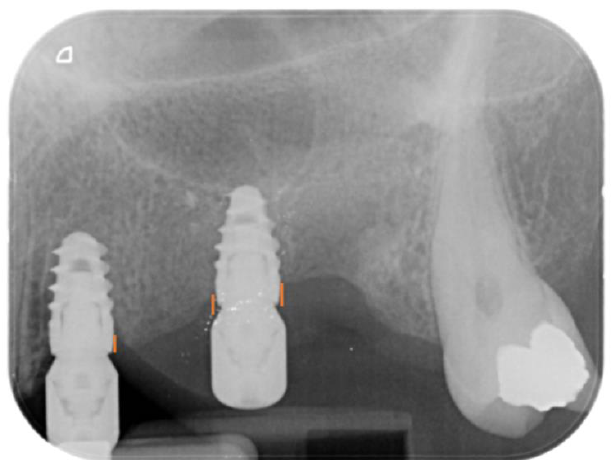
Figure 5. Periapical X-rays showing the distance between the implant-abutment interface and the most coronal aspect of the bone. Left implant: implant with machined abutment; Right implant: implant with superlattice abutment.